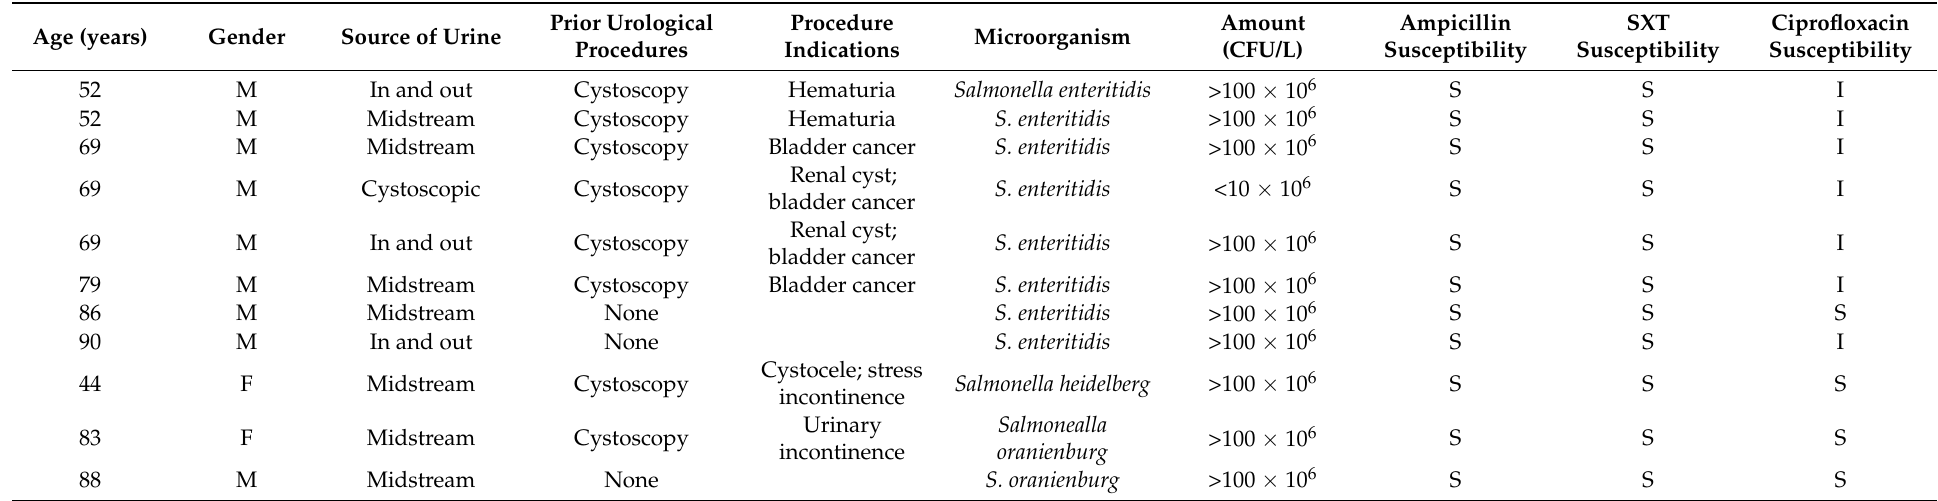
Table 2. Patients identified to have Salmonella bacteriuria in 2017–2019, sorted by names of the